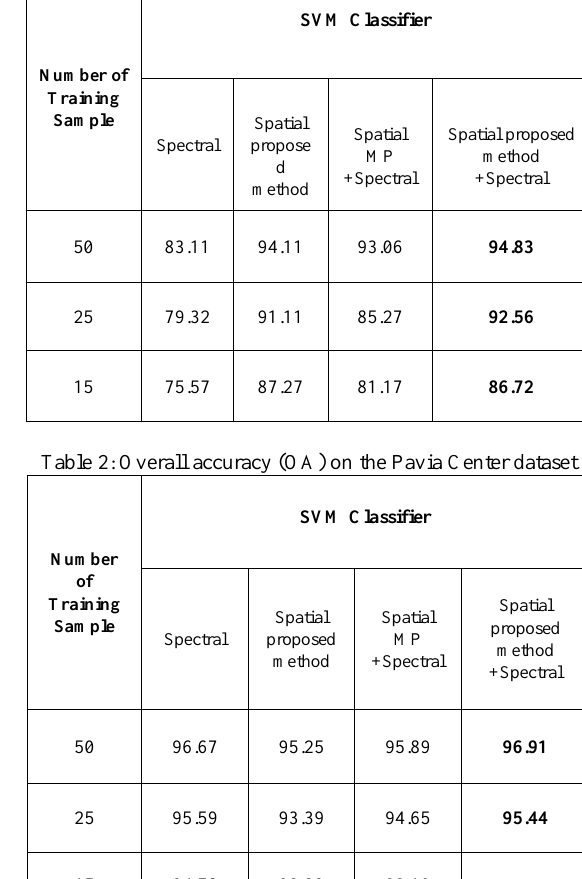
Figure 2. Represents the University of Pavia dataset, Italy, including the RGB map and 9 classes land cover